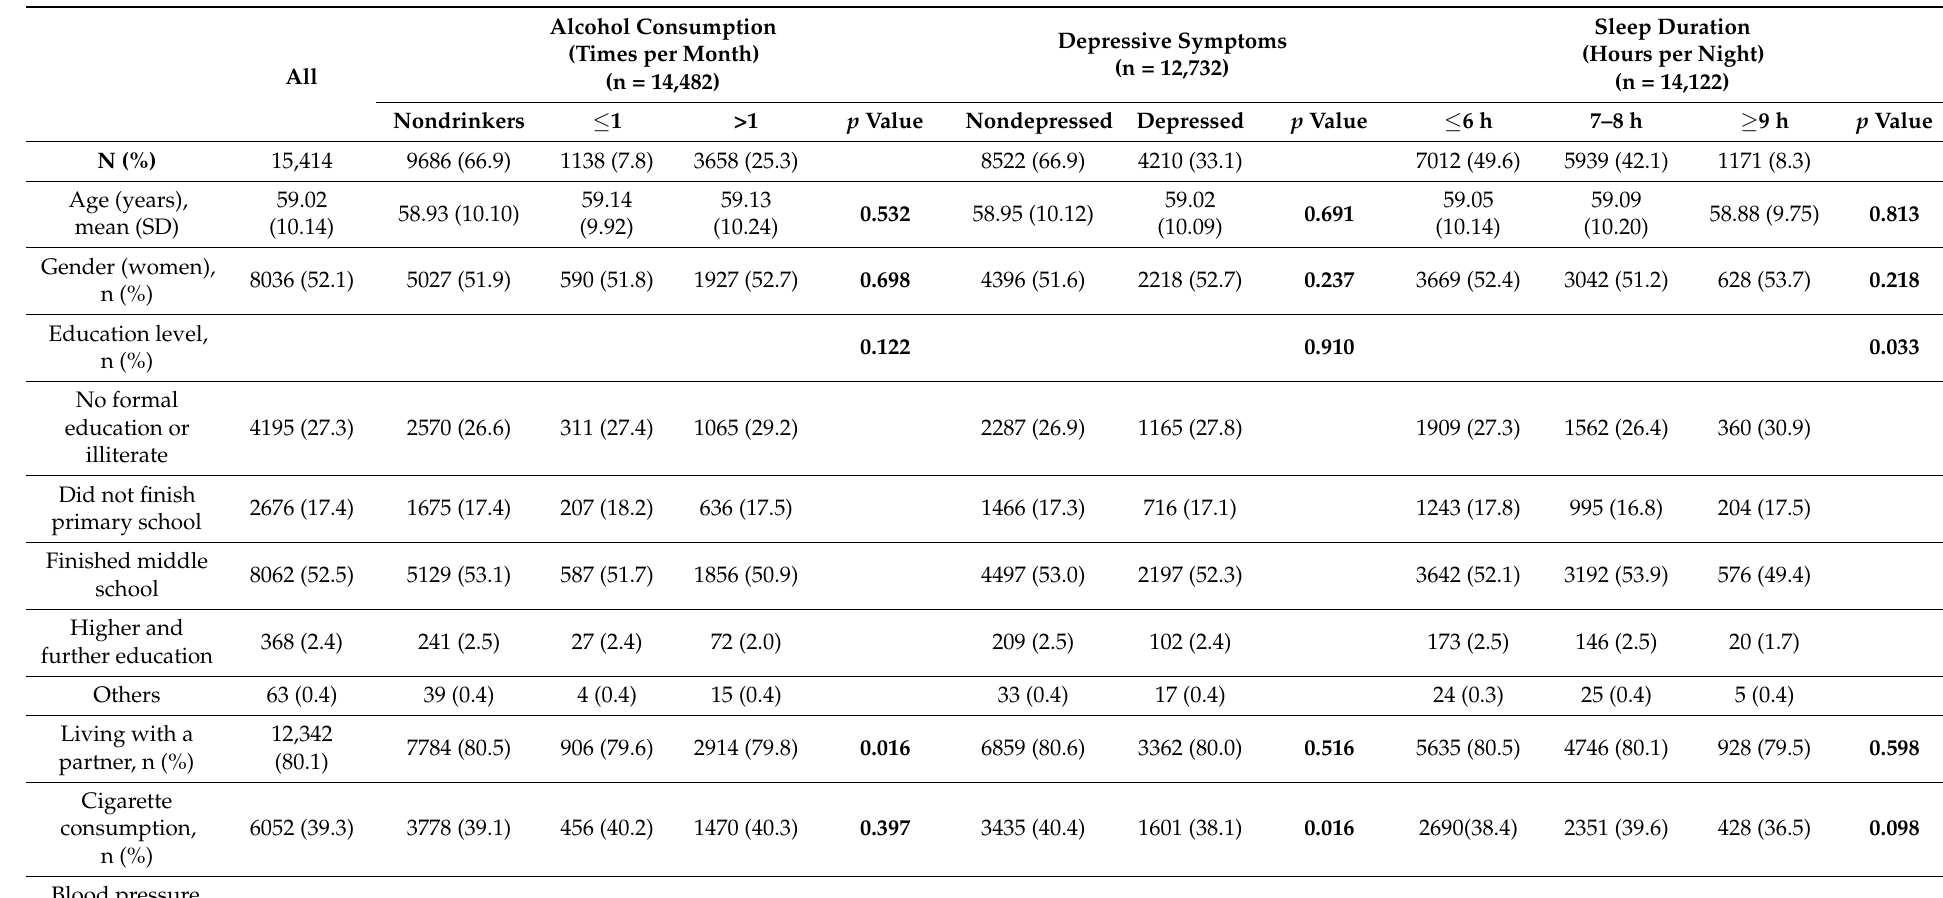
Table 1. Baseline characteristics and differences between groups of the study population (totals and stratified according to alcohol consumption, depressive symptoms, and sleep